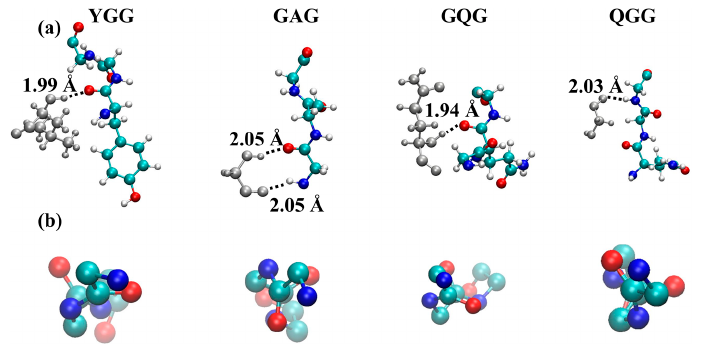
Figure 5. Representative structures of 3 1 -helices in the simulations. ( a ) shows the motifs with hydrogen-bonding partners; while ( b ) shows the backbone atoms along the helical axis. Hydrogen, oxygen, nitrogen, and carbon are indicated in grey, red, blue and green, respectively. Hydrogen bonds with neighboring strands are indicated by dotted lines, and their lengths are given.